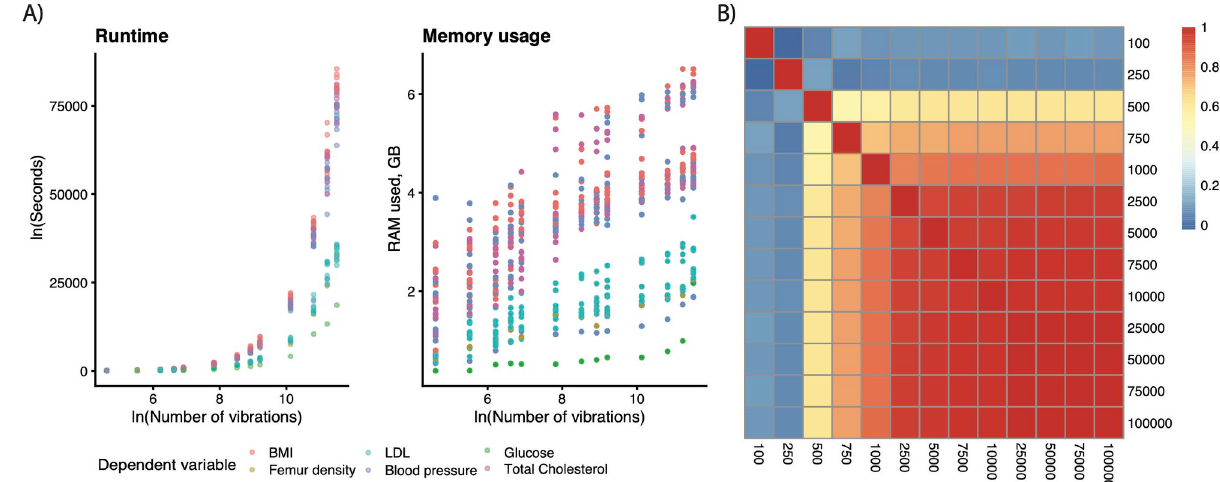
Fig 5. Software performance statistics. (A) Runtime for different numbers of vibrations, (B) memory usage for different numbers of vibrations, and (C) consistency of results across the number of vibration associations (n). Heatmap color depicts the correlations between the coefficients in the nonmixed effects version of Eq (10). Data underlying these plots are available at https://figshare.com/account/home#/projects/120969. BMI, body mass index; LDL, low-density lipoprotein.